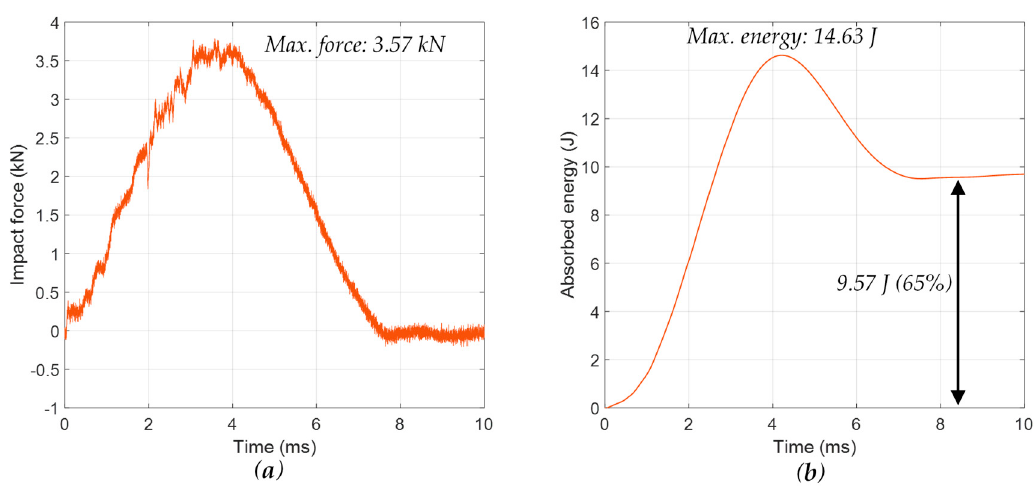
Figure 6. Force–time history and absorbed energy of the 2-mm [ − 45/90/45/0] 2S quasi-isotropic composite coupon: ( a ) force history; ( b ) absorbed energy.